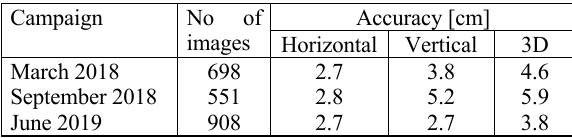
Table 1 . Accuracy of image block bundle